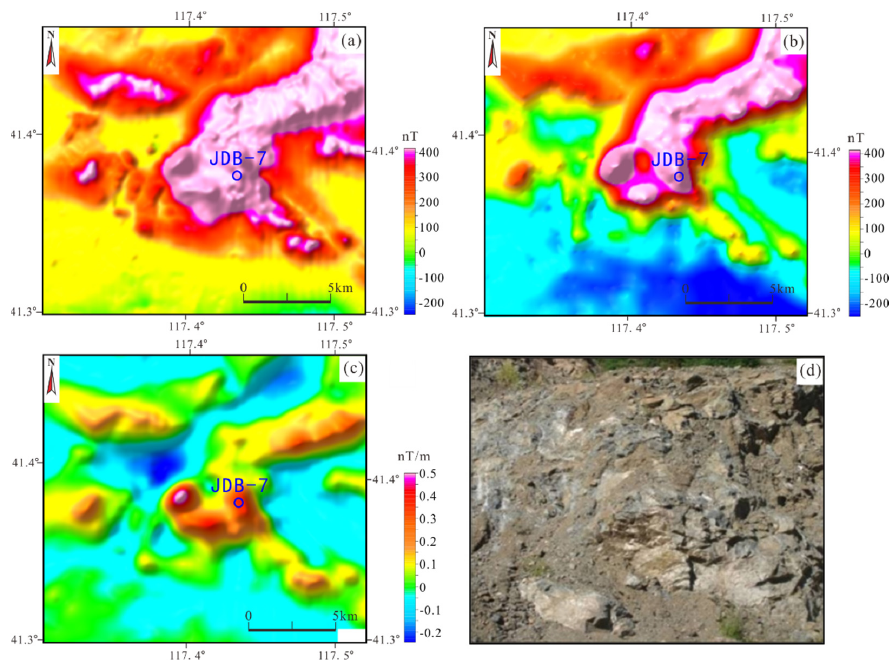
Figure 9. Aeromagnetic anomaly JDB-7 and its corresponding magnetite deposit: ( a ) Aeromagnetic data ∆ T, ( b ) reduction to the pole of aeromagnetic data ∆ T, ( c ) the first vertical derivative of reduction to the pole of aeromagnetic data ∆ T, ( d ) photograph of iron deposit mined. 6.2.4. Ore Prediction Region of Iron Polymetallic in Beierying (I-4) The Neoarchean metamorphic rocks exposed on the surface of the prediction region.